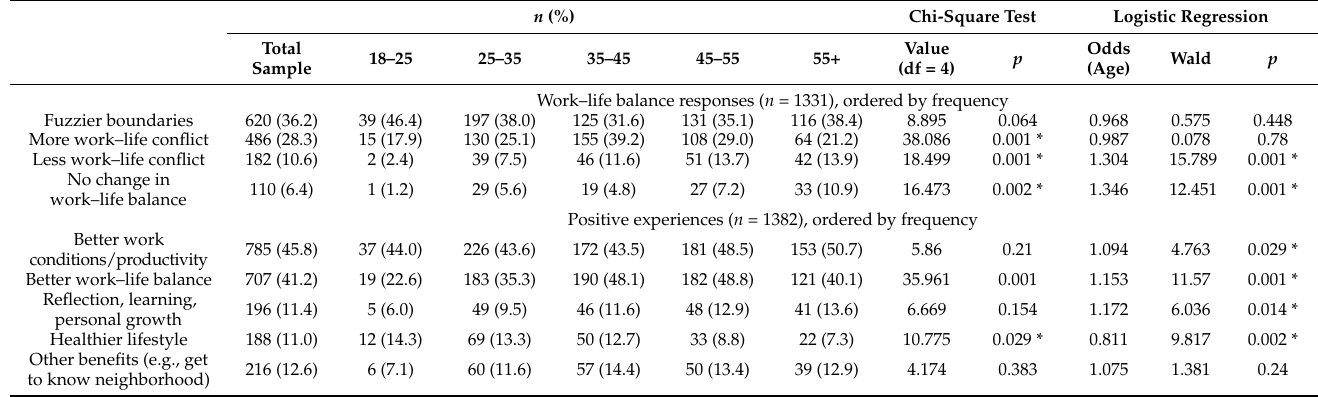
Table 4. Age group differences in main category codes for work–life boundaries and seeing positives. n (%) Chi-Square Test Logistic